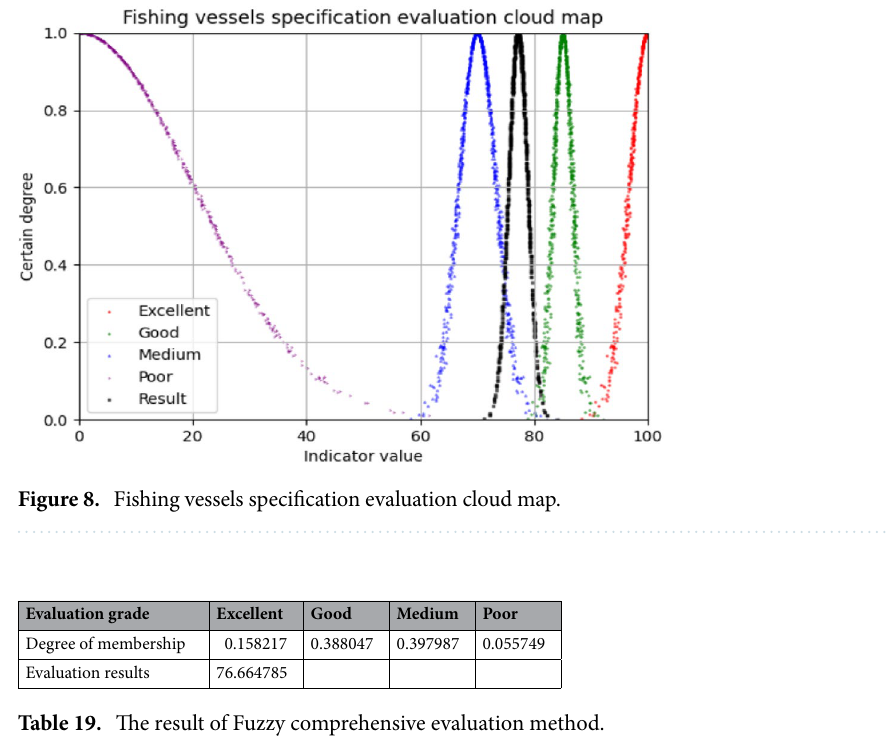
Table 19. The result of Fuzzy comprehensive evaluation method.